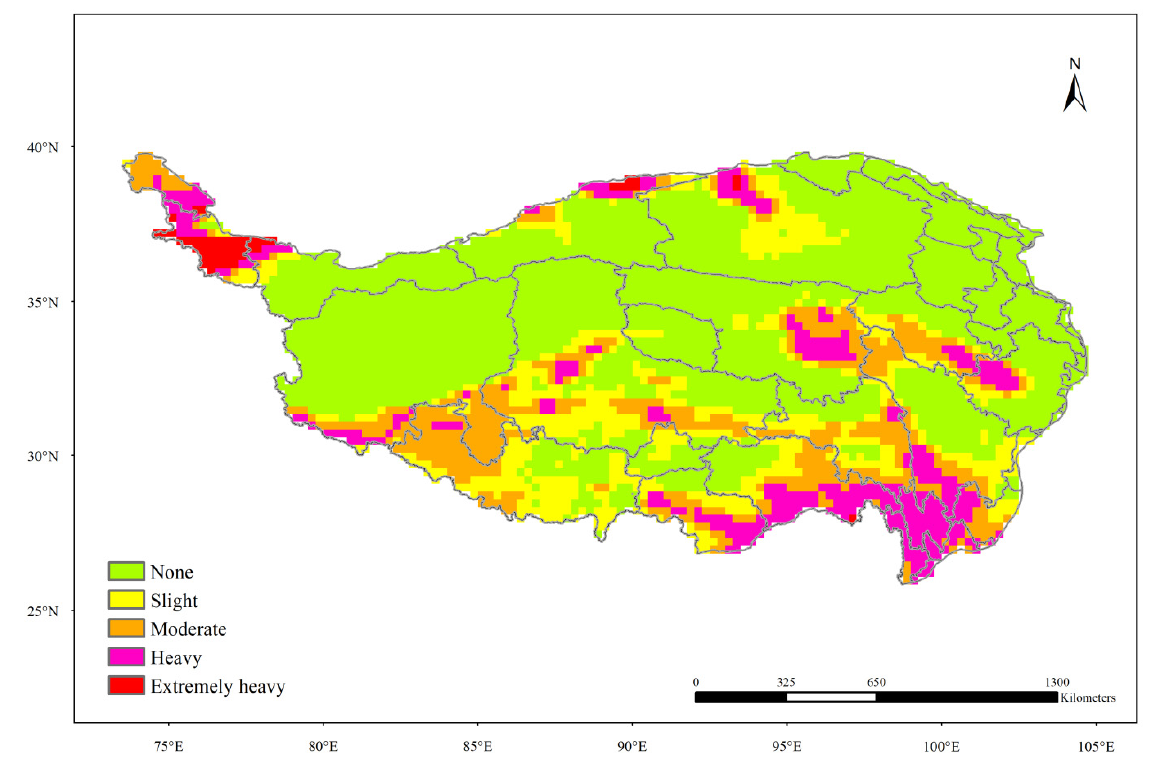
Figure 7. Spatial distribution of the average grade of snow disaster on the QTP.